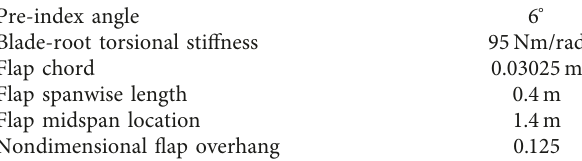
Figure 4: Predicted and measured SPL noise contours (6th–40th BPF). (a) Measured; (b) predicted. Table 1: The main parameters of a sample ECR.